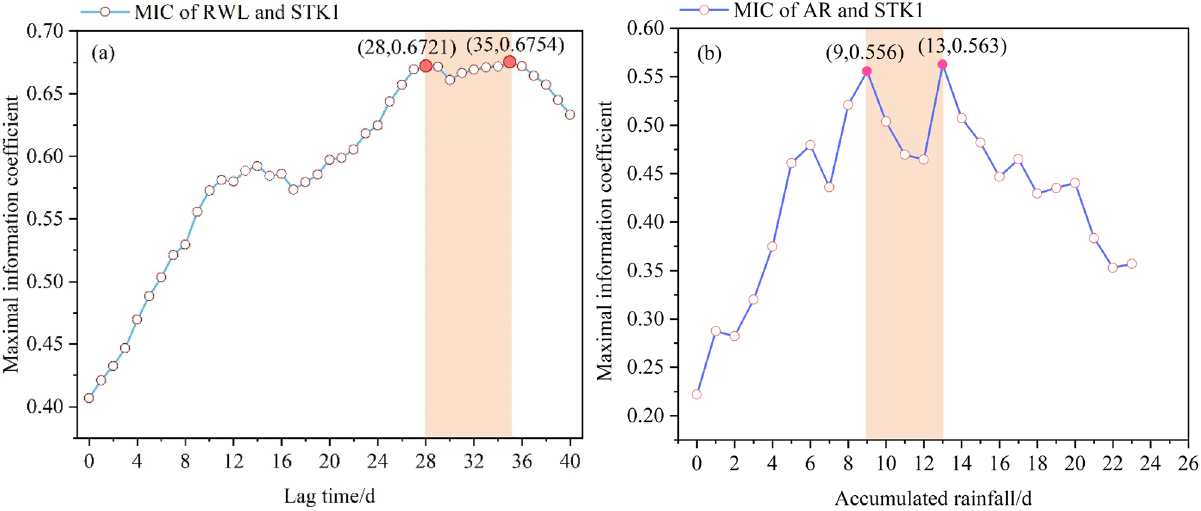
Figure 13. The MIC of the GWL and triggering factors: ( a ) the reservoir water level; ( b ) the accumulated